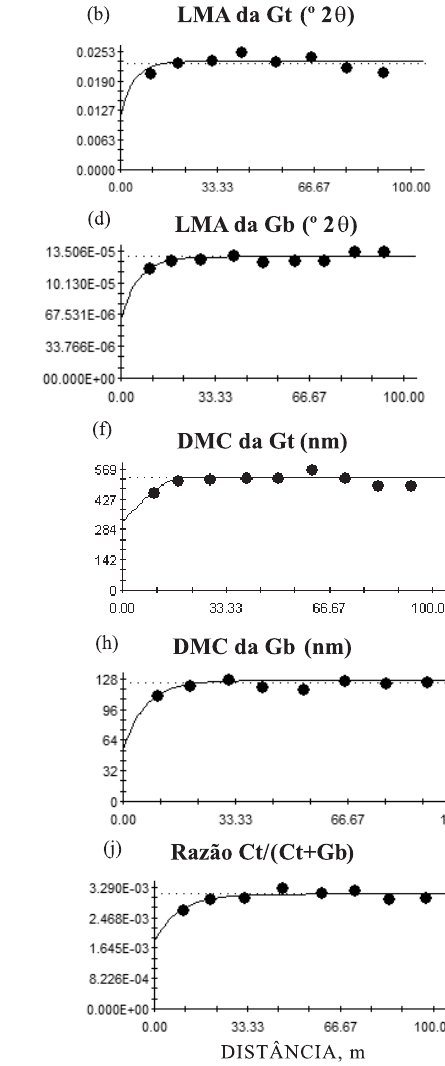
Figura 2. Semivariogramas dos atributos: largura à meia altura (LMA), diâmetro médio do cristal (DMC) dos minerais hematita (Hm), goethita (Gt), caulinita (Ct) e gibbsita (Gb) e razões Gt/(Gt+Hm) e